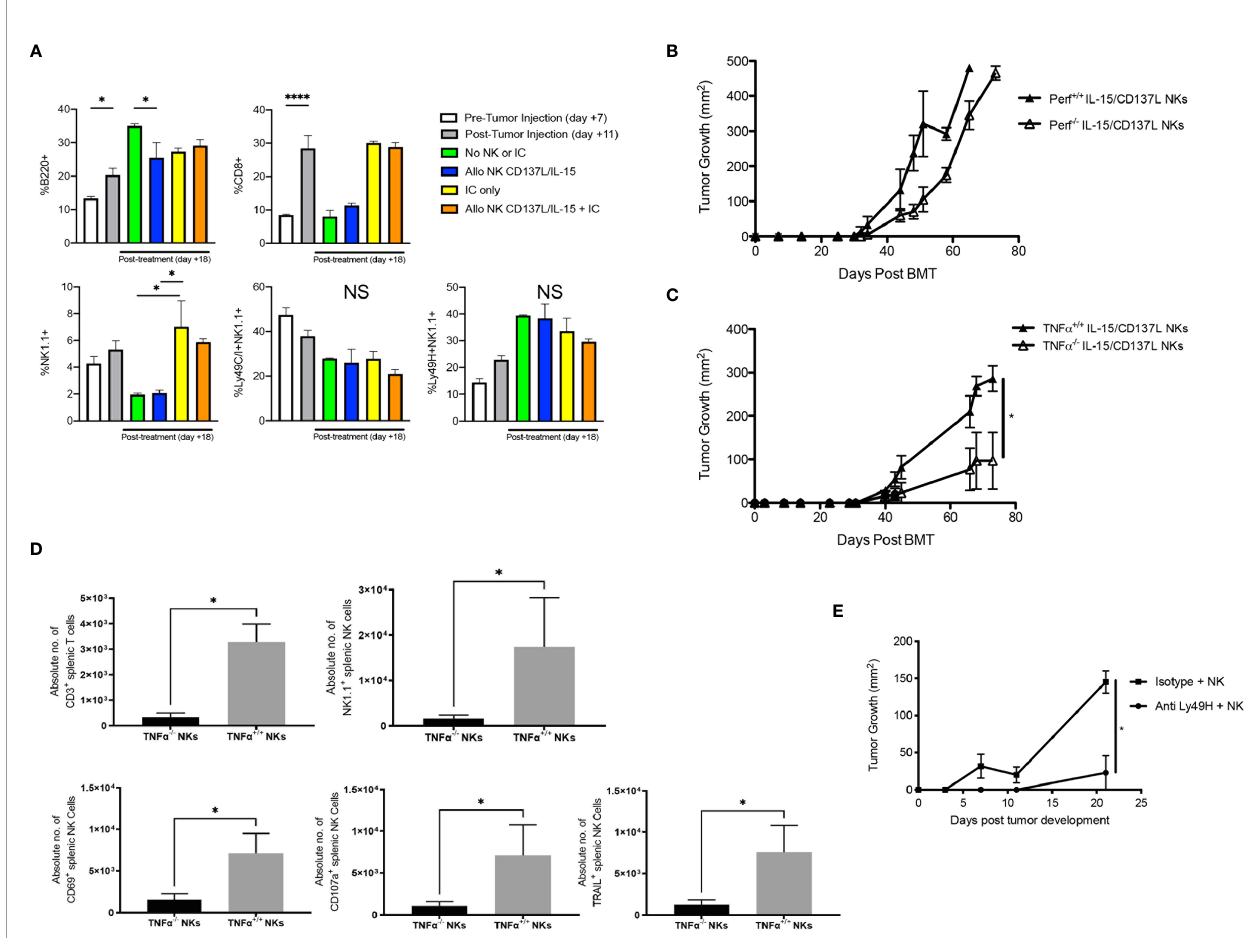
FIGURE 6 | Impact of infusing ex vivo CD137L/IL-15/IL-15R a expanded NK cells on GD2 + NXS2 neuroblastoma growth after allogeneic HSCT. Lethally irradiated A/J mice (H-2 a ) were transplanted with CD3e cell depleted B6 BM (H-2 b ) with 2.5 x 10 2 B6 T cells on Day +0. On Day +10, 2 x 10 6 NXS2 tumor cells were inoculated into the right fl ank. On Days +14-16, hu14.18-IL-2 (IC) was administered. (A) Flow cytometric analysis of the spleen was performed on Day +7 (pre- NXS2), +11 (post-NXS2, pre-IC or NK cells) or +18 (post-IC and/or NK cells). (B) On Day +16, select groups were infused with 2.5 x 10 6 CD137L/IL-15/IL-15R a expanded NK cells from B6 wild type (Perf +/+ ) or B6 Perforin (Perf -/- ) donors, or (C) B6 wild type (TNF a +/+ ) or B6 TNF a -/- donors. (D) Both spleens and tumors were harvested from recipients of B6 wild type (TNF a +/+ ) or B6 TNF a -/- donors at Day +30 and analyzed for T cells and NK cell subsets. (E) Mice were transplanted and challenged with NXS2 as above but on Day +16 were infused with 2.5 x 10 6 CD137L/IL-15/IL-15R a expanded NK cells from B6 wild type and then treated with anti-Ly49H depletion or an isotype control. All mice were followed for NXS2 tumor growth. N=3-5 mice/group. *p < 0.05. ****p < 0.001. NS, not signi fi